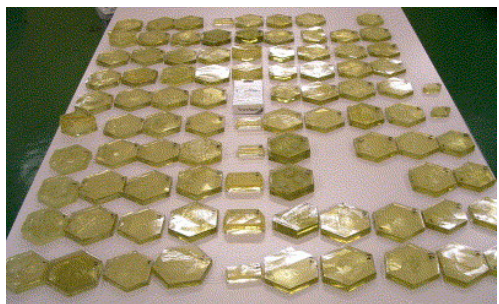
Figure 3. Two-inch size ZnO crystals produced during one hydrothermal growth run. Reprinted from Ehrentraut, D., Sato, H., Kagamitani, Y., Sato, H., Yoshikawa, A., Fukuda, T., Solvothermal growth of ZnO, Progress in Crystal Growth and Characterization of Materials 2006 , 52, 280–335; doi:10.1016 / j.pcrysgrow.2006.09.002, Copyright (2006), with permission from